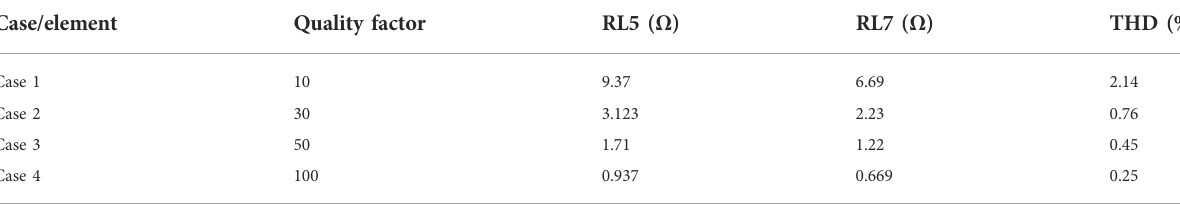
TABLE 2 Before applying the priority method.